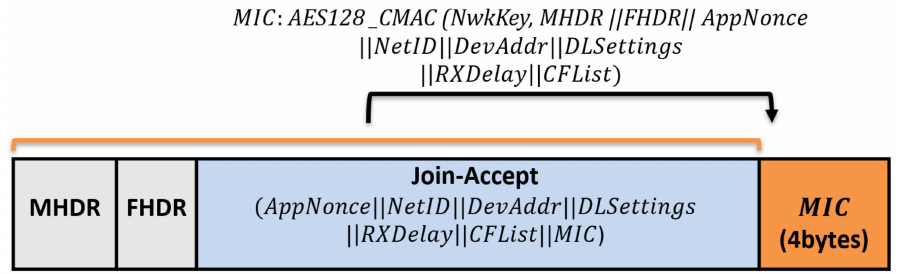
Figure 4. The structure of Join-Accept